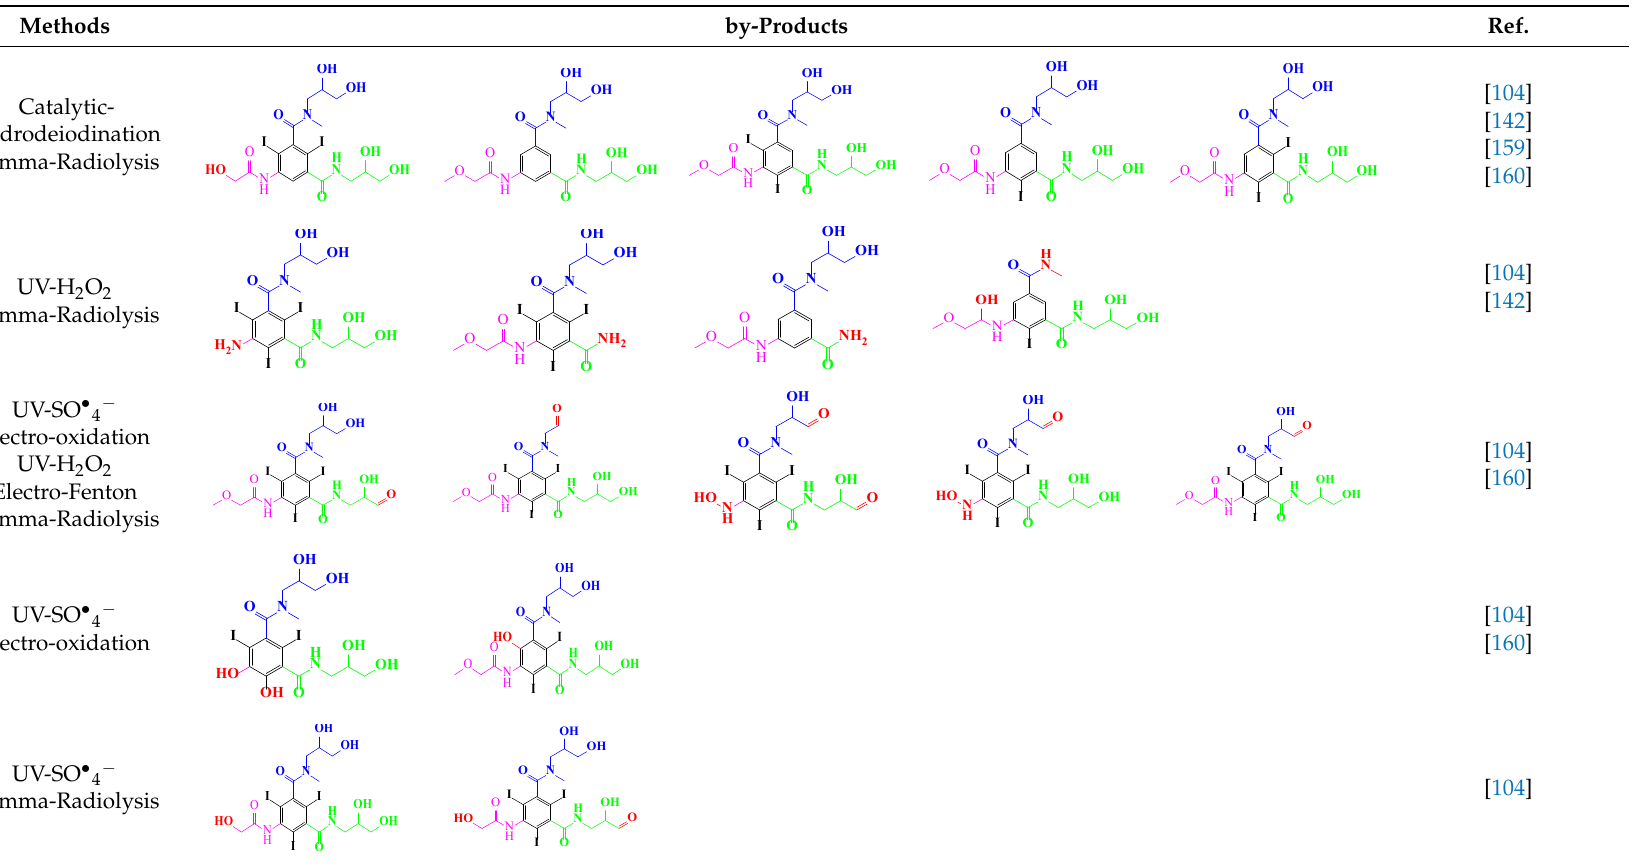
Ref. Ref. Ref. Ref.